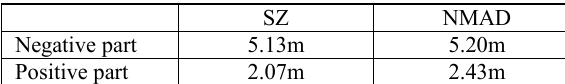
Fig. 3: Color coded difference reference DTM – Fig. 4: Frequency distribution with overlaid normal distribution CoSSC DSM based on SZ and on